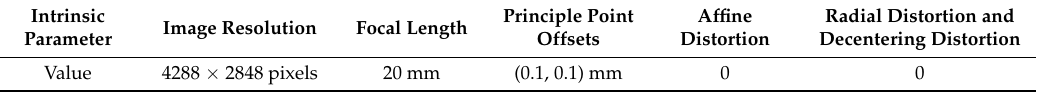
Figure 2. Schematic diagram of the synthetic experiment using the PUMA560 model. Table 1. Intrinsic parameters of the virtual camera for the synthetic experiment.